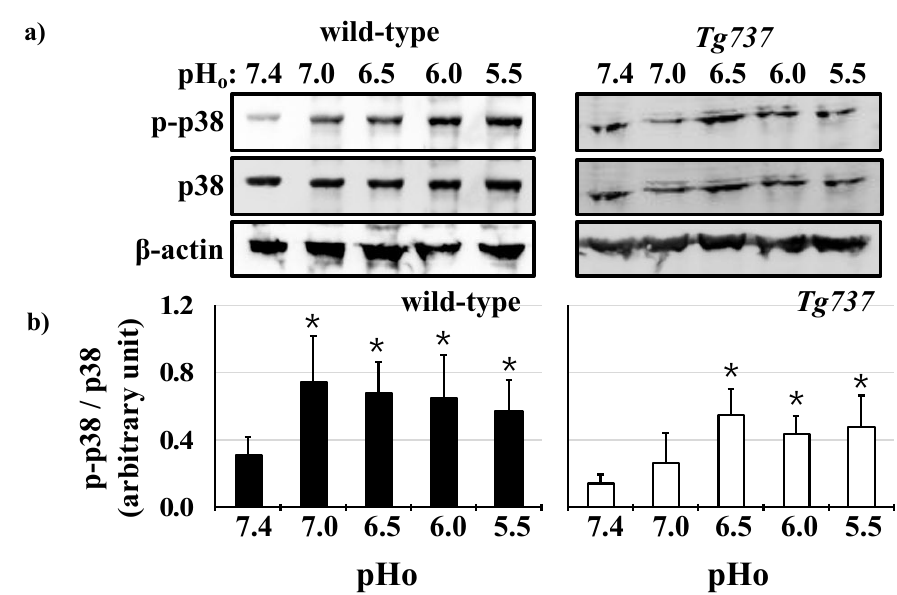
Figure 4. p38 phosphorylation by decreased extracellular pH in wild-type and Tg737 cells. ( a ) Representative immunoblots show p38 phosphorylation in wild-type and Tg737 cells as they are exposed to media of decreasing extracellular pH (pH o ) from 7.4 to 5.5. ( b ) Bar graph shows mean p-p38 / p38. Significant increase in p-38 phosphorylation occurs when pH changes from 74. to 7.0. But in Tg737 cells the pH had to drop to 6.5 before significant changes in p38 phosphorylation was observed. * indicates p < 0.05 as compared to control pH o 7.4; N = 8 for wild-type cells and N = 8 for Tg737 cells.